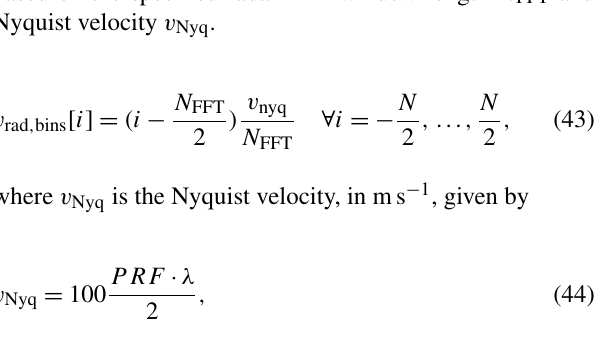
based on the specified radar FFT window length N FFT and